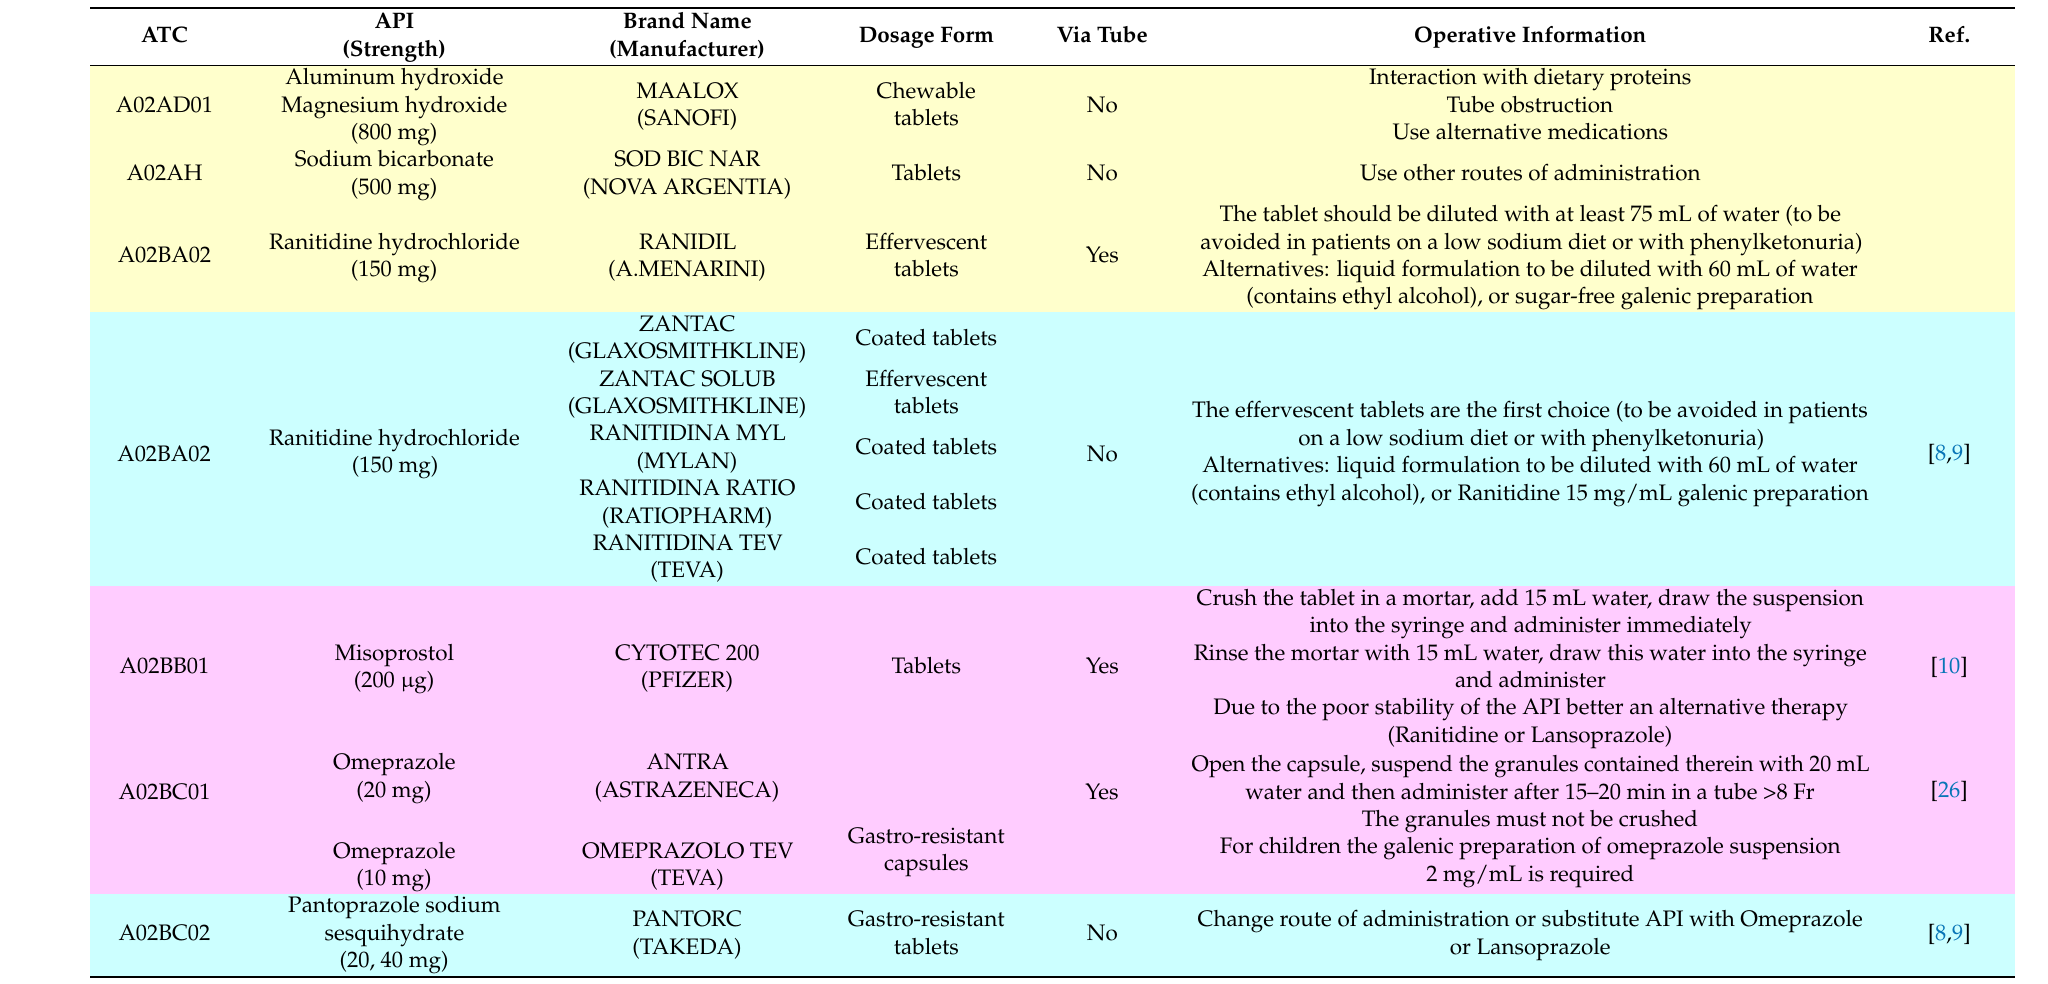
Table 3. General suggestions for the oral solid medications listed in the Savona hospital formulary given by tube. The sources of the information are highlighted in different colors according to their level of reliability. Green, level A (SmPC); light blue, level B (Guidelines); pink, level C (literature); yellow, level D (pharmacist